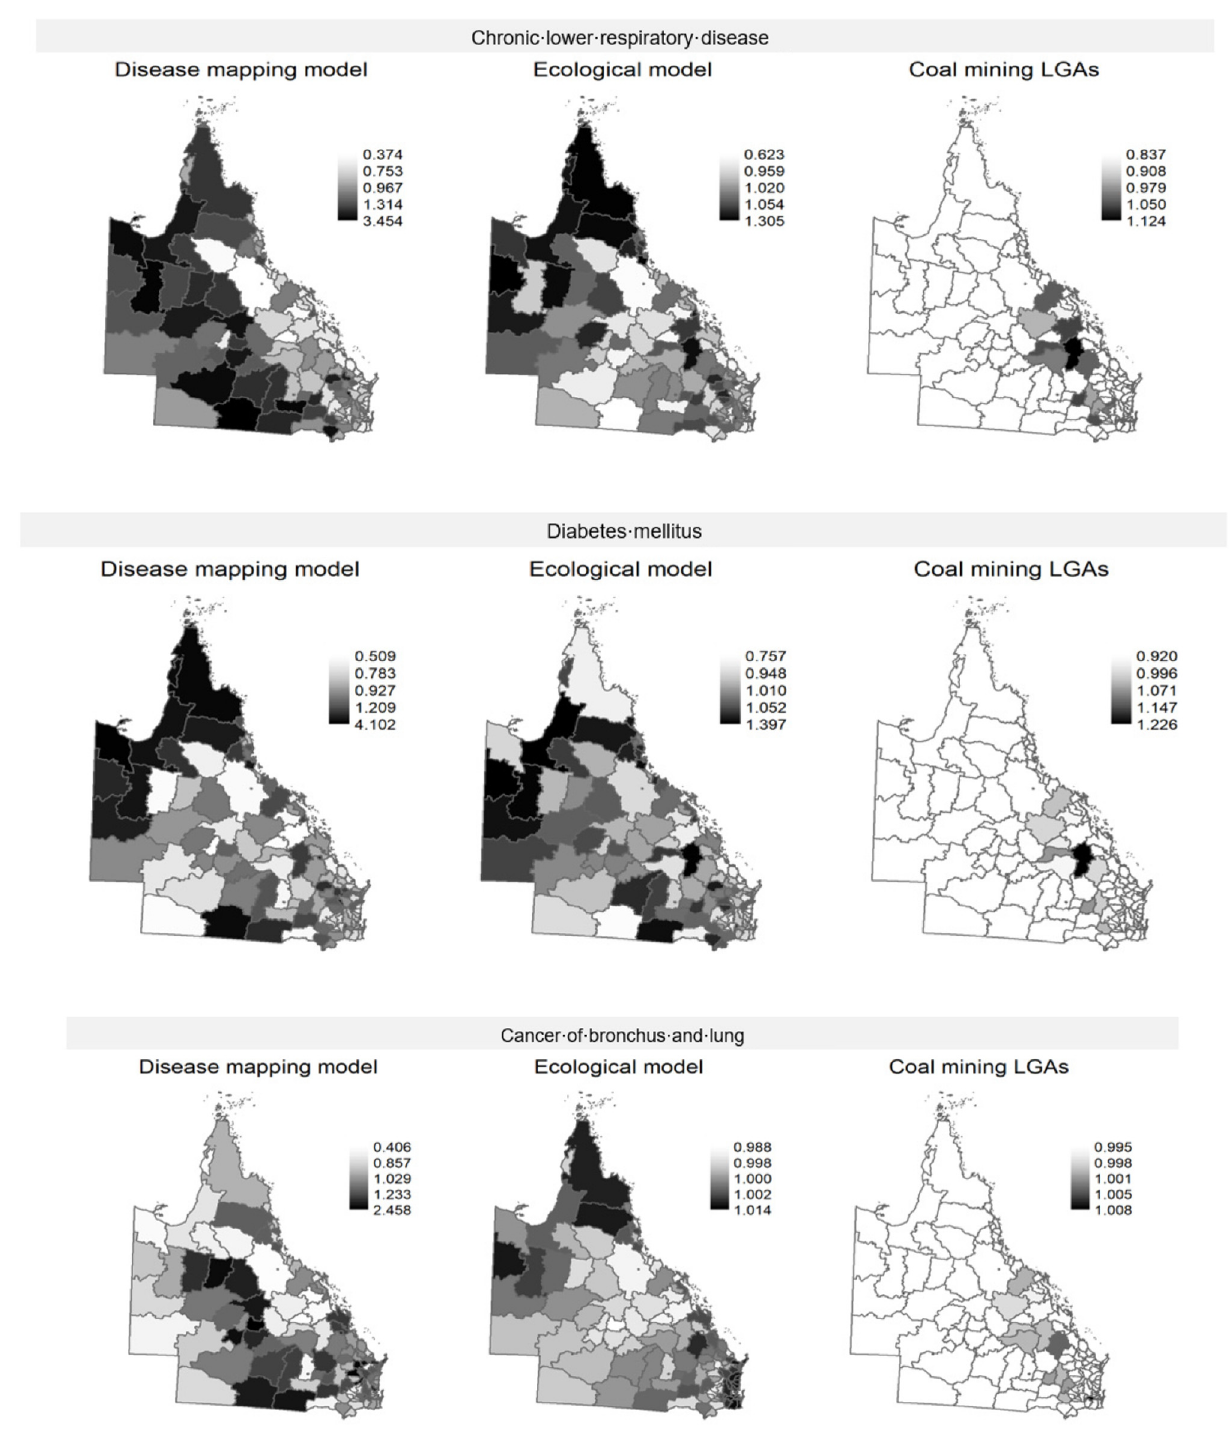
Figure 1. LGA-specific risk of hospitalisation (relative to the whole of Queensland) in the disease mapping and ecological models, and relative risk of hospitalisation estimated in the ecological model for the LGAs with coal mining activities only (coal mining LGAs).